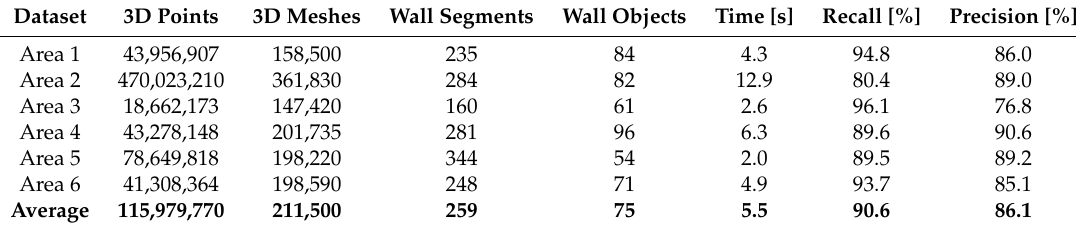
Table 1. Results of the CRF method on the 2D-3D-S